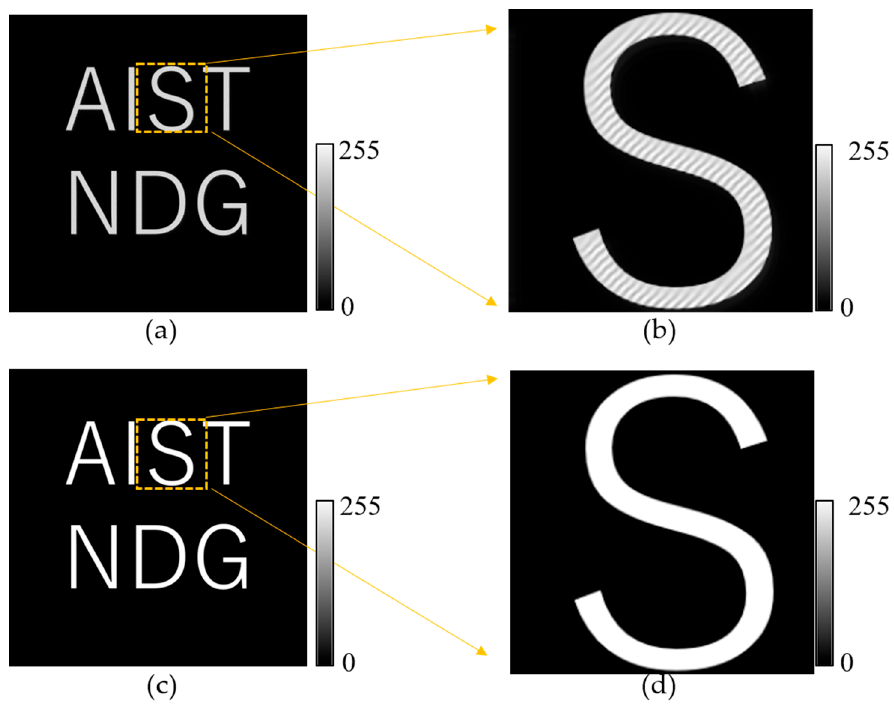
Figure 4. Simulated object and an example of the generated hologram. ( a , b ) Amplitude and phase distributions; ( c ) Example of the generated hologram; ( d ) Magnified image of the area indicated in ( c ).